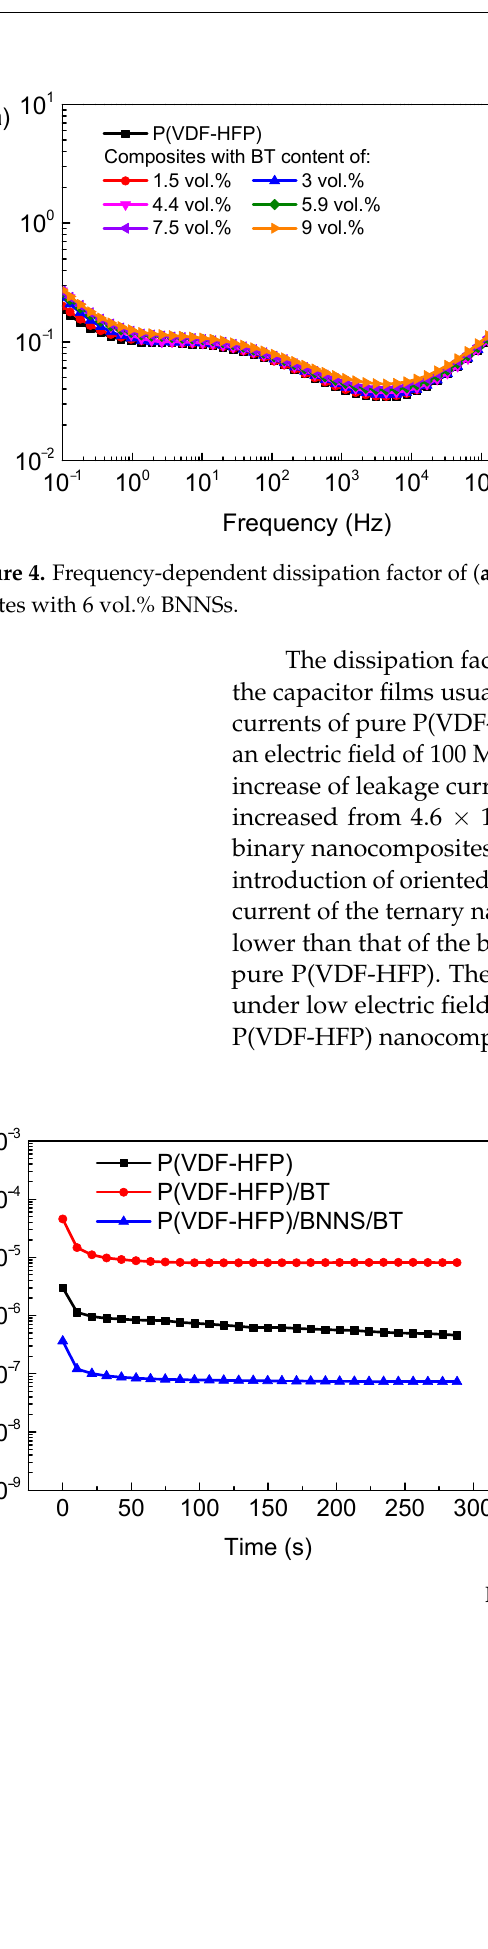
Figure 5. ( a ) Leakage current density of P(VDF-HFP), P(VDF-HFP)/BT, and P(VDF-HFP)/BNNS/BT nanocomposites under the electric field of 100 MV/m. The characteristic breakdown strength and shape parameter of ( b ) P(VDF-HFP)/BT and P(VDF-HFP)/BNNS/BT nanocomposites as a function of BT content and ( c ) P(VDF-HFP)/BNNS nanocomposites as a function of BNNS content.